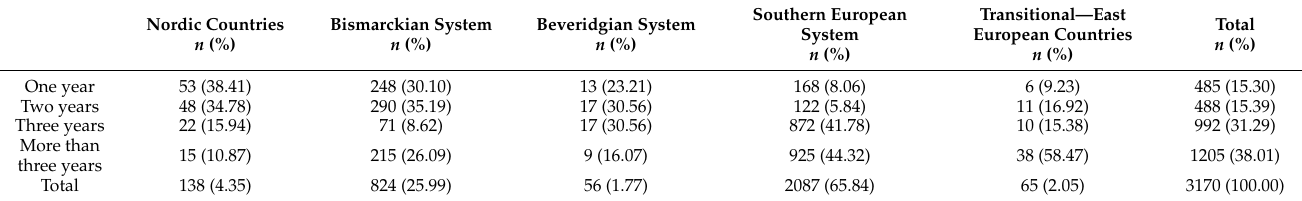
Table 2. Association between the oral health care system and planning period to own a practice. Nordic Countries n